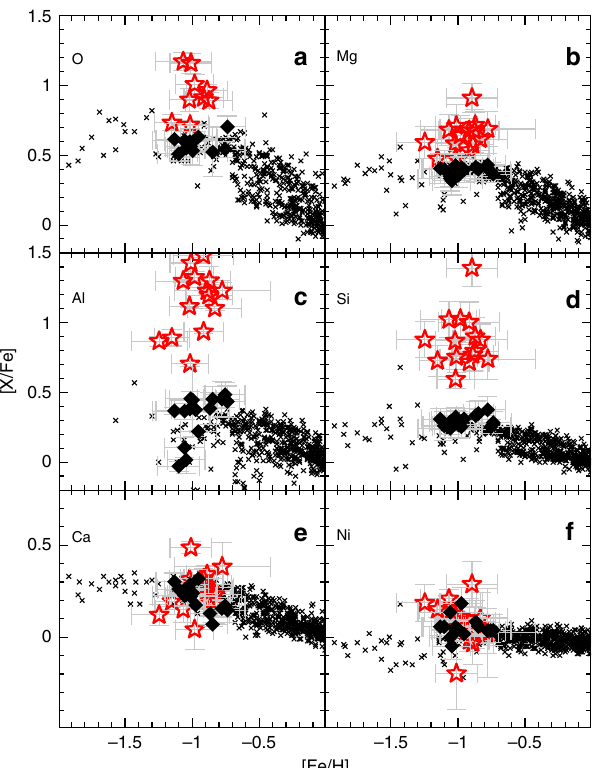
Fig. 9 Elemental abundances as a function of metallicity. a Oxygen, b magnesium, c aluminum, d silicon, e calcium, f nickel. The red stars and black diamonds show the P-rich and P-normal stars, respectively, while the black crosses correspond to the optical literature values for fi eld dwarf stars 48 . Error bars indicate our measurement uncertainties such as displayed in Supplementary Tables 3 and